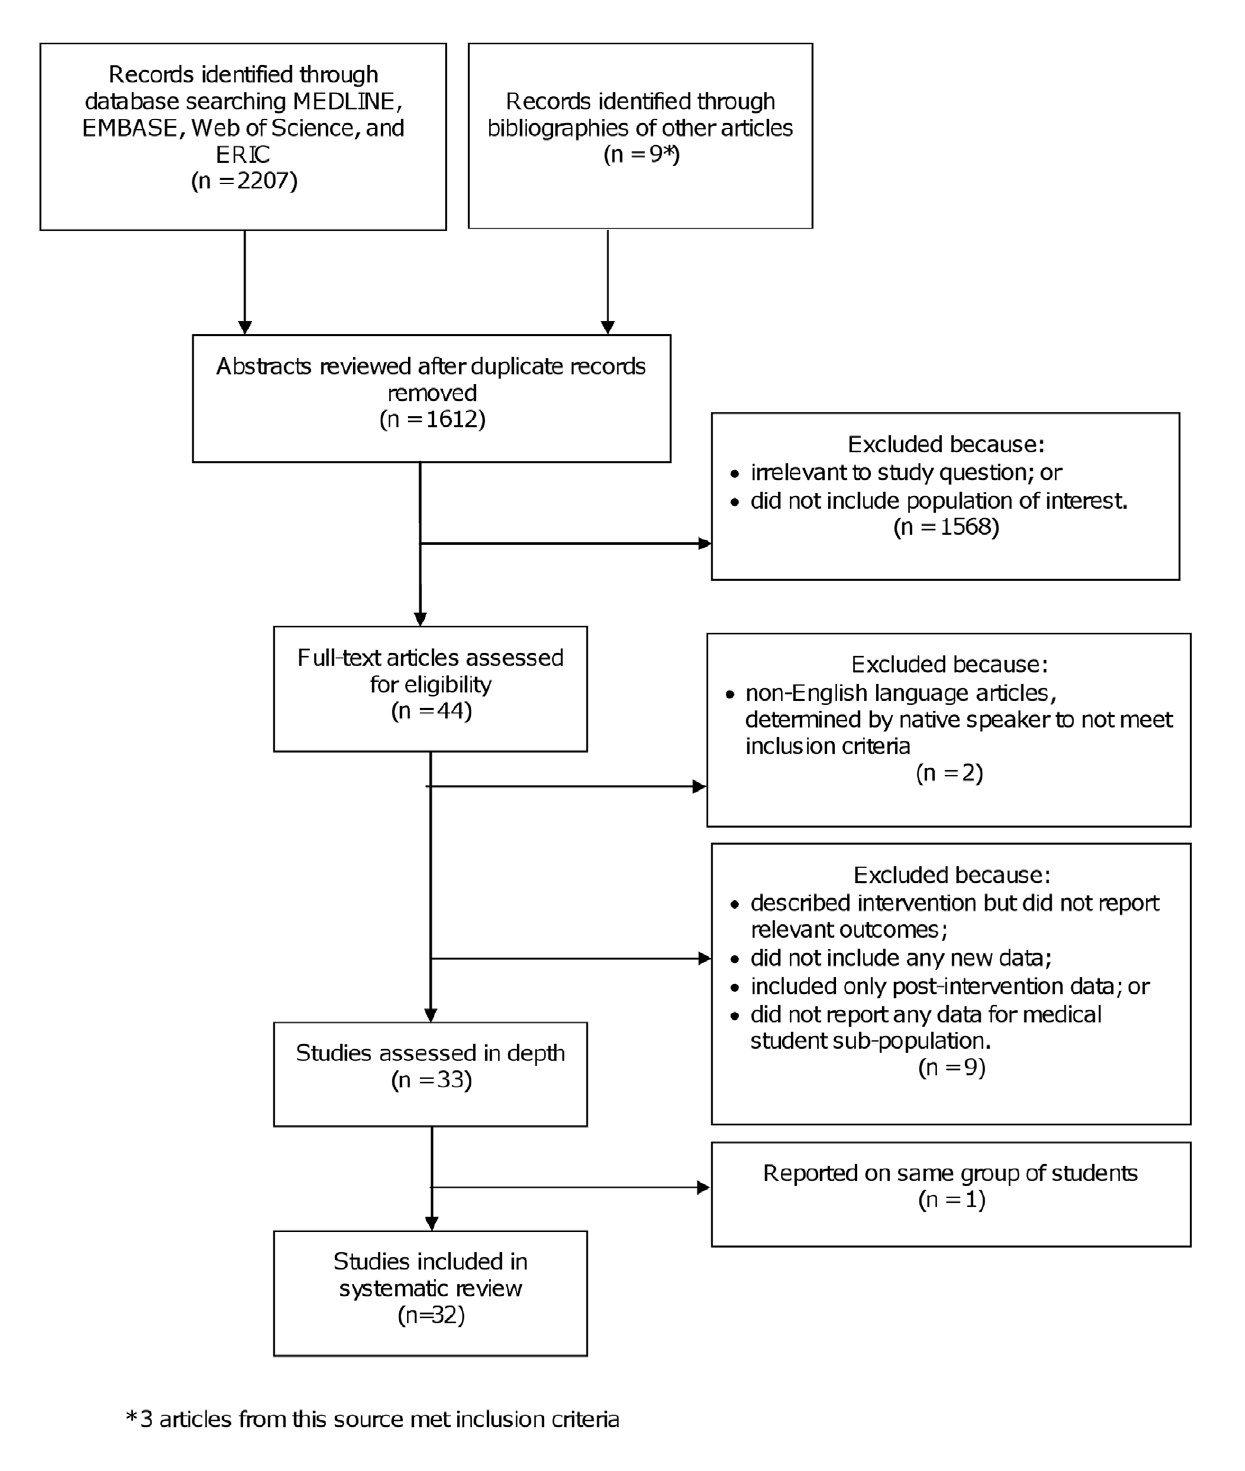
Figure 1. PRISMA schematic of systematic review search process.